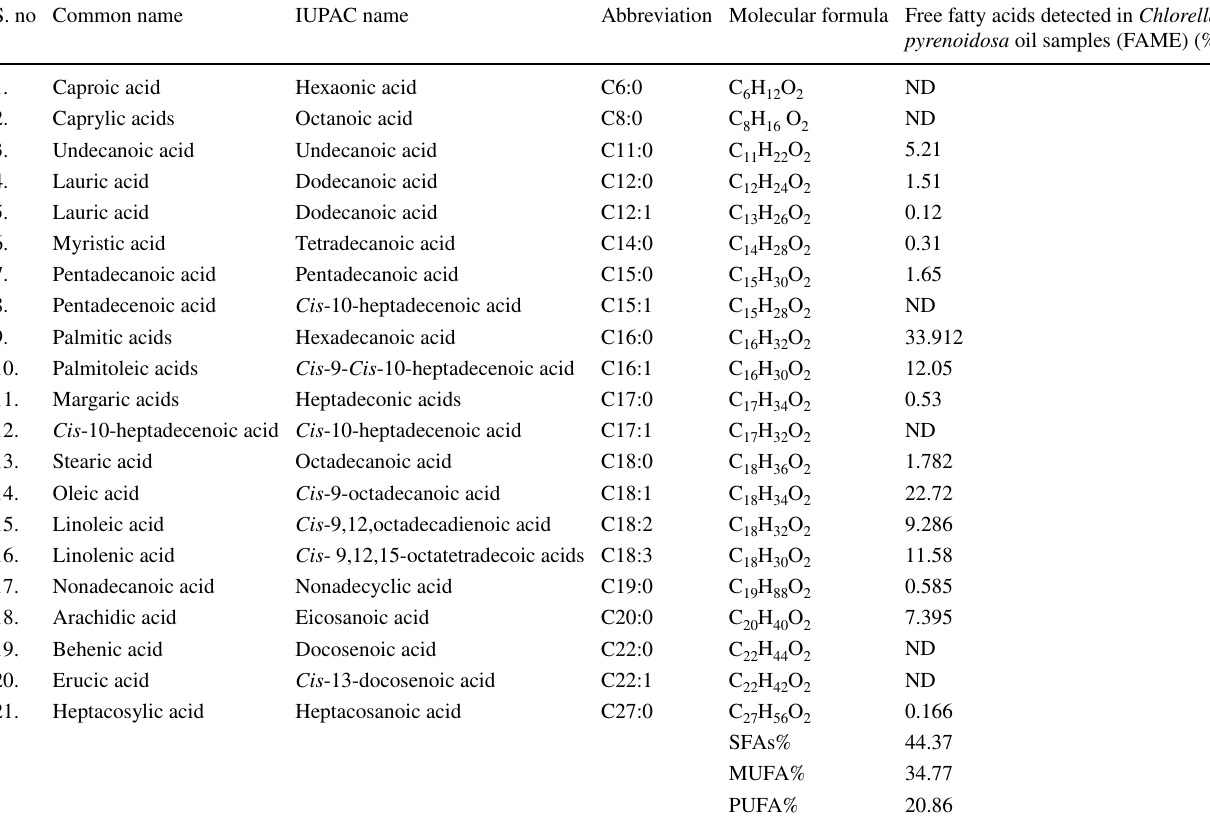
Table 5 Analysis of free fatty acids (FFAs) of Chlorella pyrenoidosa